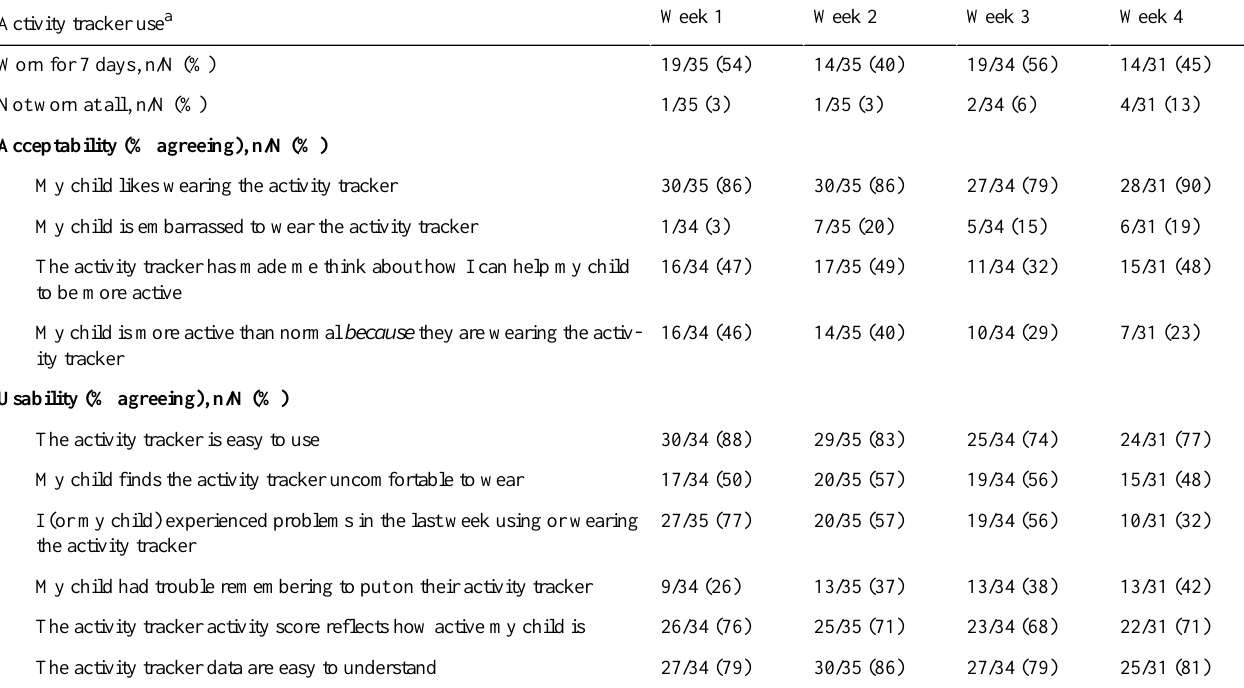
Table 1. Descriptive survey data on wearable activity tracker use and perceptions among parents (parents were asked to complete 1 survey per